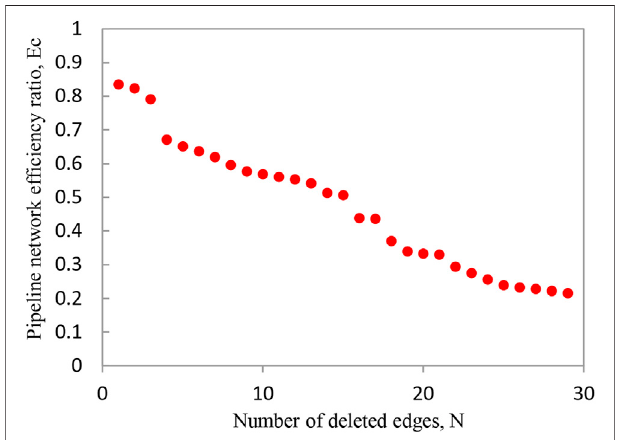
FIGURE 16 | The network robustness diagram under the random disturbance caused by different